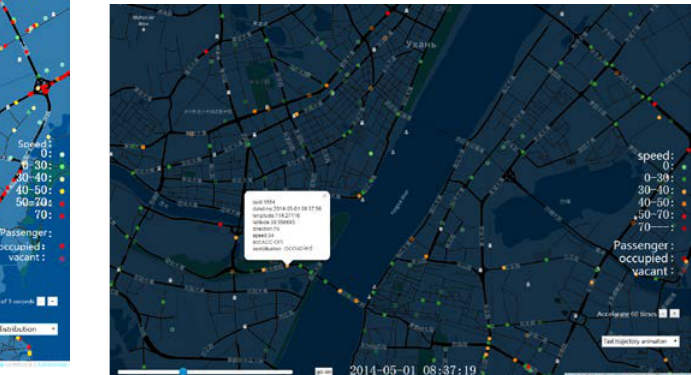
Figure 10. Detailed information of a